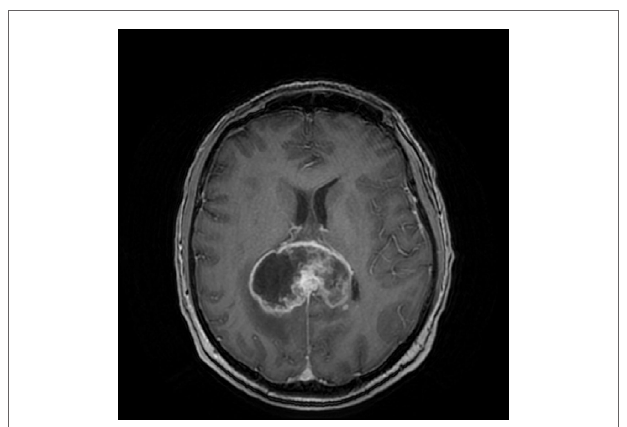
FIGURe 1 | Coronal, post-contrast t1 image of a posterior human butterfly GBM